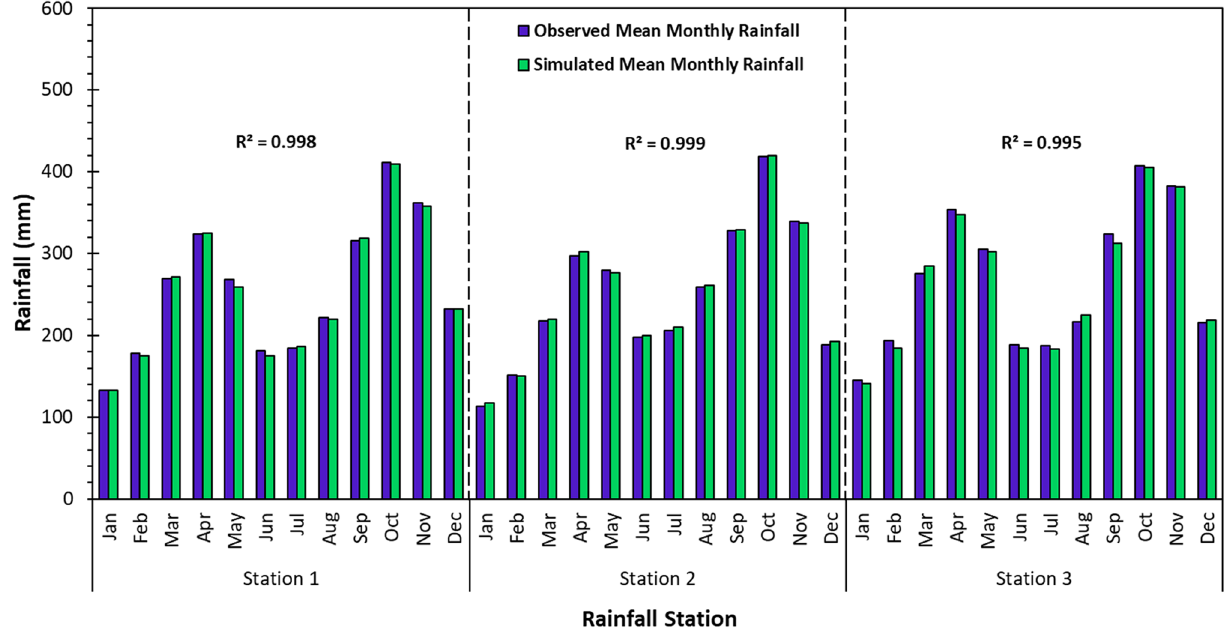
Fig. 2 Comparison of observed and model-simulated mean monthly rainfall at three